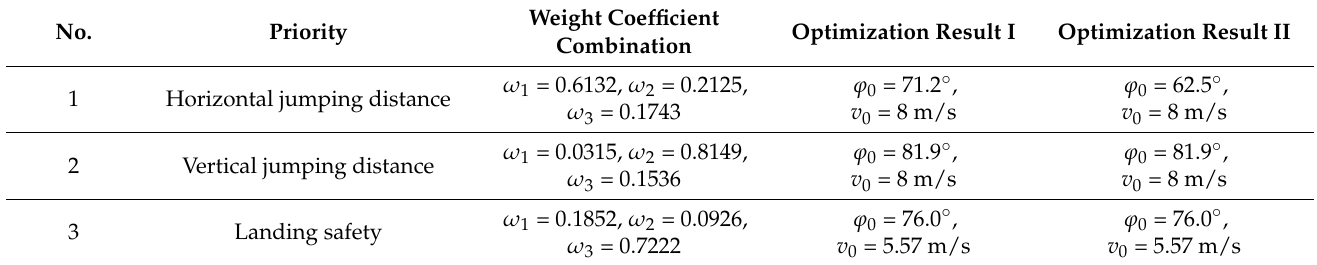
Table 5. Optimization results of jumping trajectory under different weight coefficient combinations.